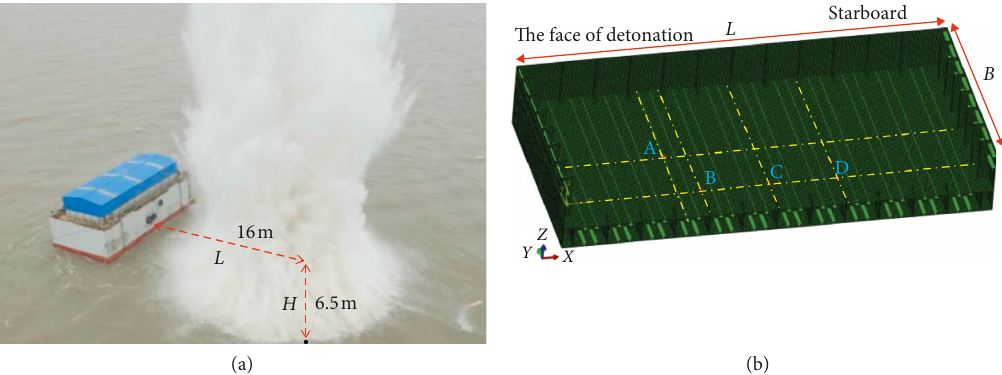
Figure 15: The explosive experiment of the IFSP. (a) Explosive experiment. (b) Test points of the Platform at the inner